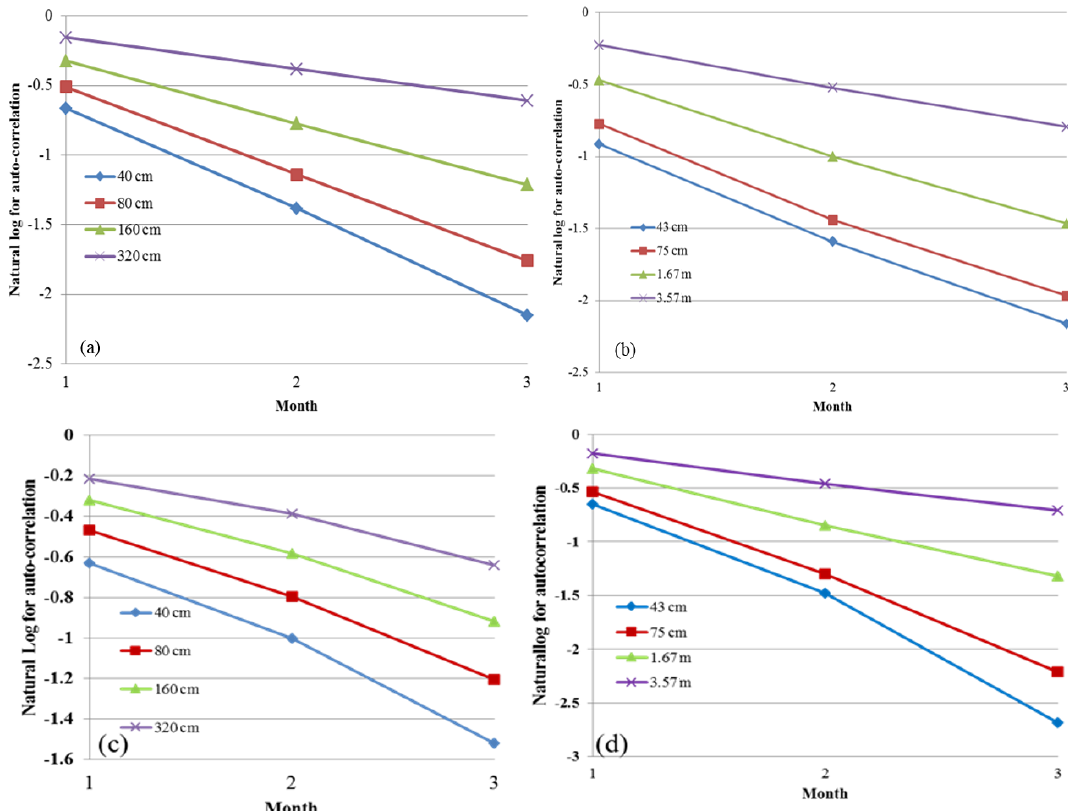
Figure 9. The natural log for the auto-correlation over NC (a, b) and the TP (c, d) for 1981–2005. (a, c) Observed; (b, d) SSiB3-FSM.